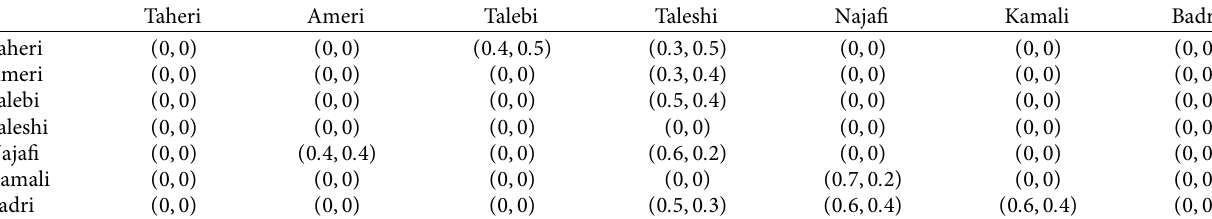
Table 4: Adjacency matrix corresponding to Figure